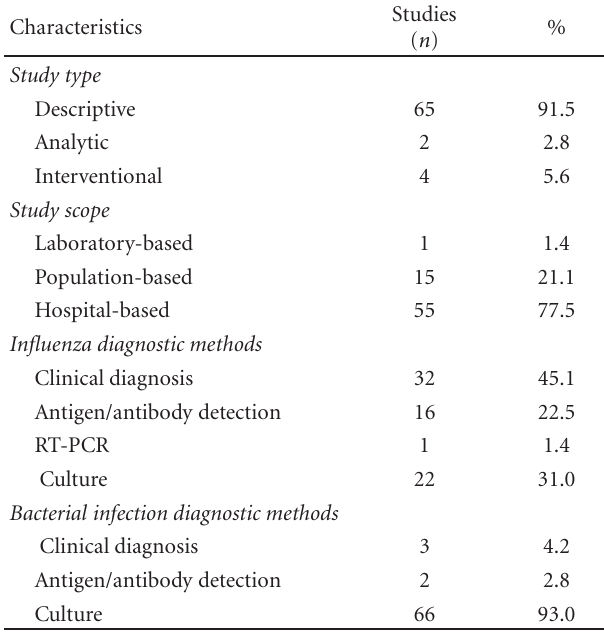
Table 1: Characteristics of studies included in analysis ( n =